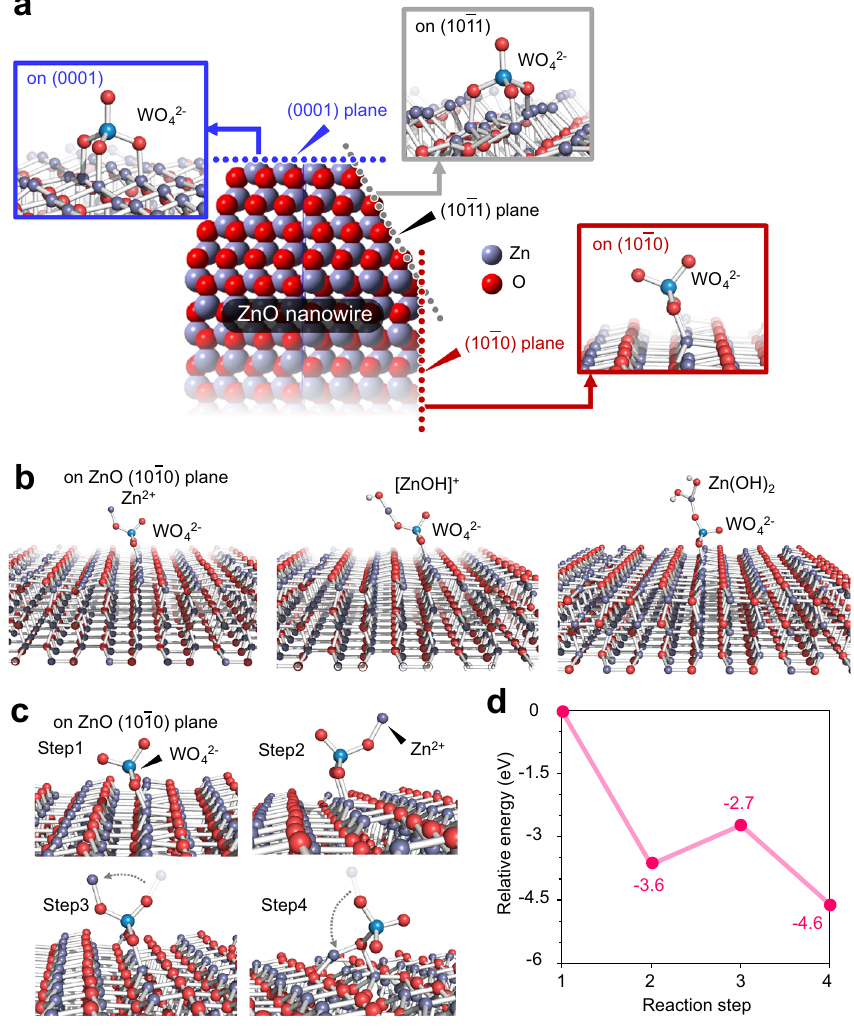
Fig. 5 Computational analyses of Zn ions and WO 4 2 − ions on ZnO crystal planes. a The coordination structures of adsorbed WO 4 2 − ion on ZnO 10 (cid:1) 10 (cid:1) (cid:3) plane, (0001) plane, and 10 (cid:1) 11 plane, respectively. b The coordination structures of WO 4 2 − ion and various Zn species (Zn 2 + , [ZnOH] + , and Zn(OH) 2 ) (cid:1) (cid:3) on ZnO 10 (cid:1) 10 plane. c The coodination structures and d relative energies of WO 4 2 − -Zn 2 + ions on ZnO 10 (cid:1) 10 The coordination structures are simulated by DFT calculation in the presence of water solvent.